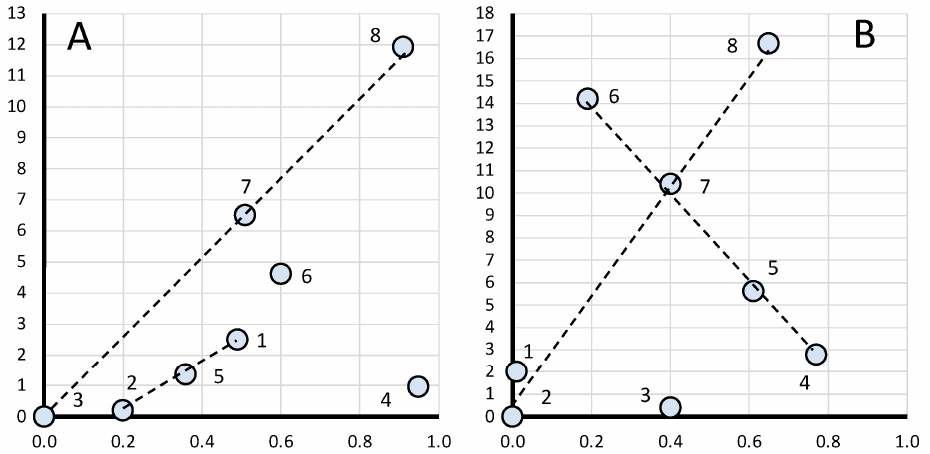
Figure 4. Fractal portraits of gene expression in the breast ( A ) and thigh ( B ) muscles of WC embryos. The X -axis shows the fractional parts of the shifted gene expression levels, and the Y -axis shows the full values of the shifted gene expression levels (Table S13). The numbers near the dots correspond to the gene numbering in Table S13. The dotted lines show that the corresponding genes belong to gene expression fractals, reflecting the fractal bioconsolidation of these genes.